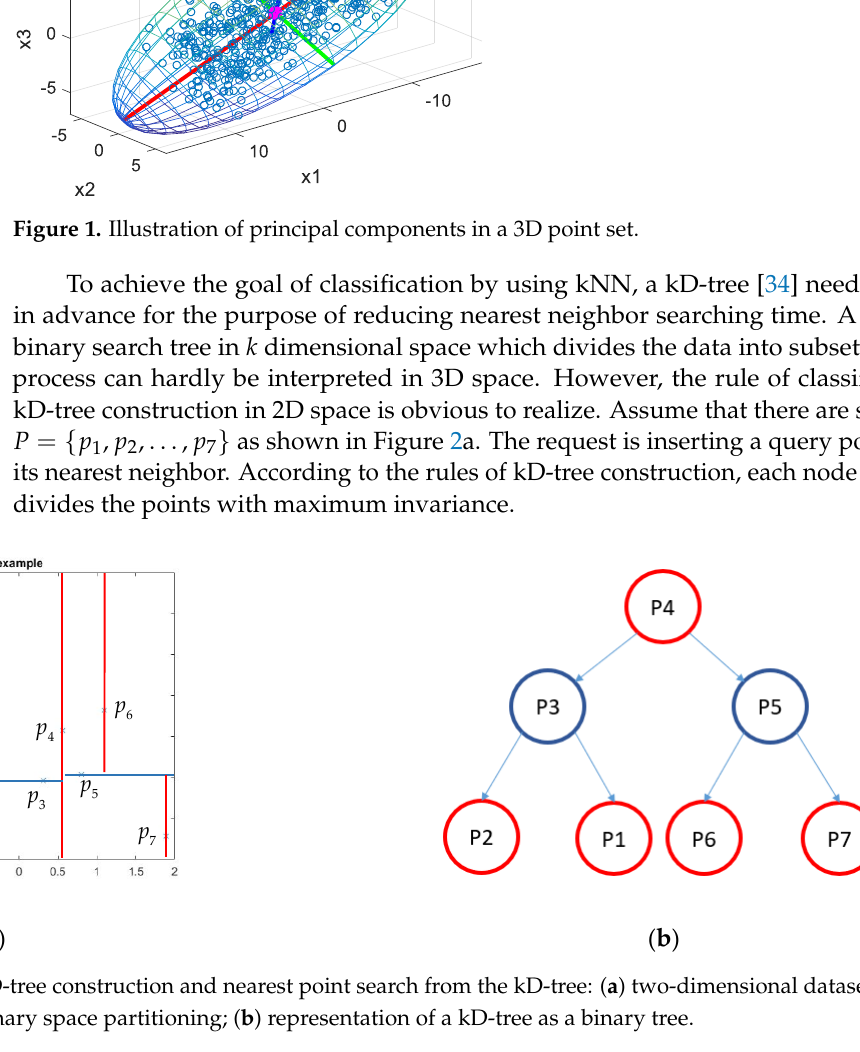
Figure 1. Illustration of principal components in a 3D point set.